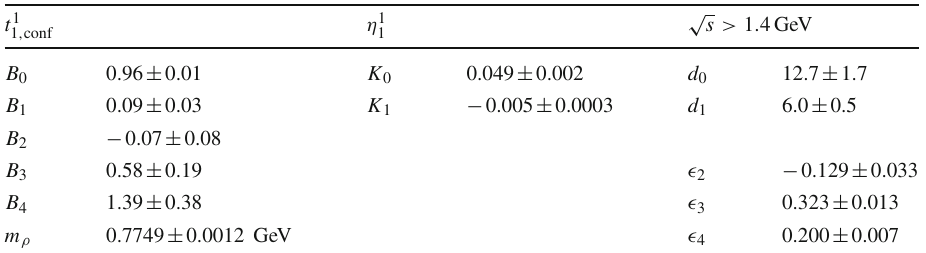
Table 9 Fit parameters of the Global parameterization for the P -wave solution II